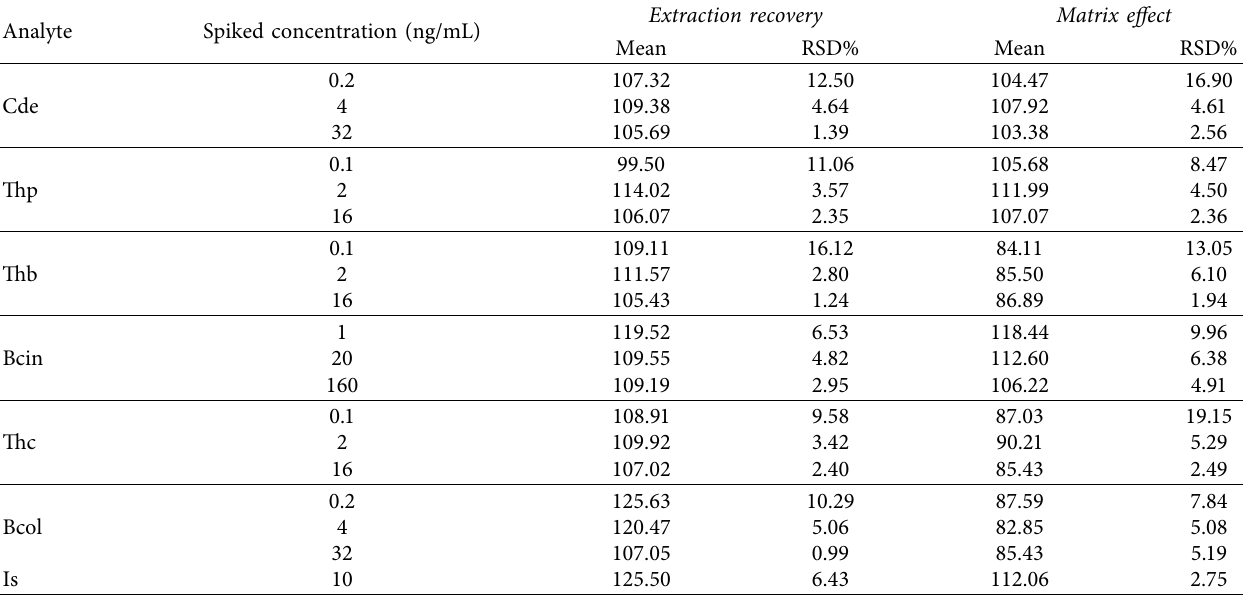
Table 6: Extraction recovery and matrix effect of the six analytes and internal standard in dog plasma (mean, n � 6). Analyte Spiked concentration (ng/mL)